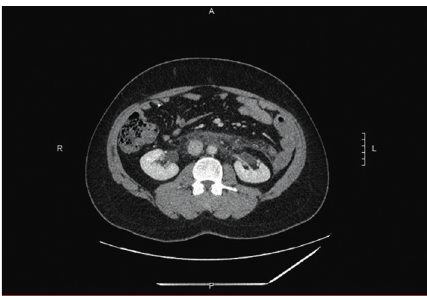
Figure 1: CTimaging of chest shows retroperitoneal stranding and edema adjacent to the transverse portion of duodenum and pos- terior to the peripancreatic head at day 1.